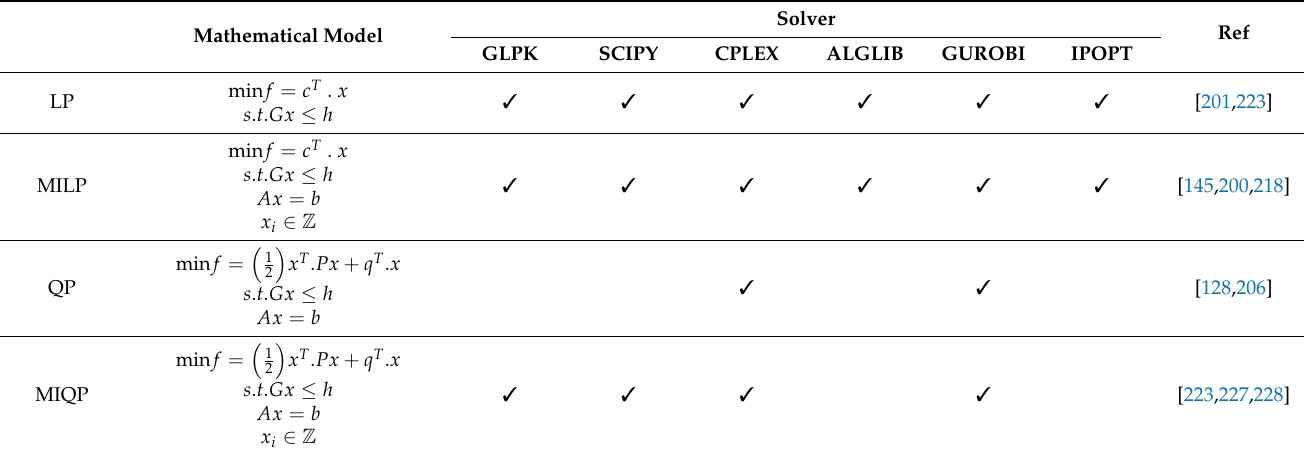
Table 9. The mathematical models and solvers for the classical